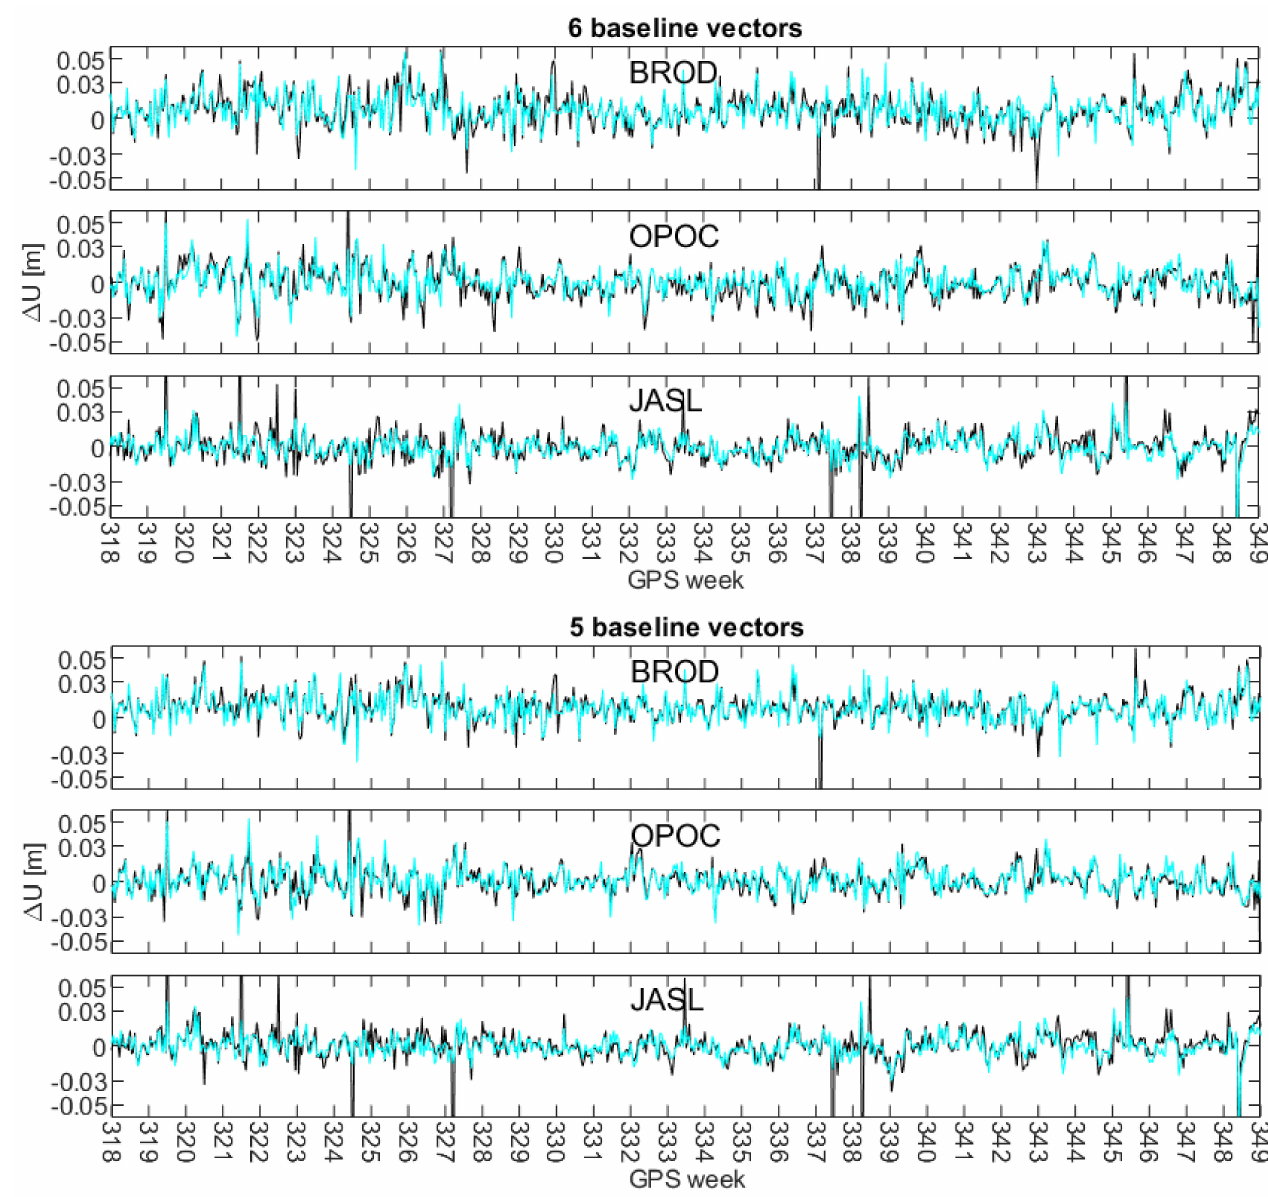
Figure 6. Time series of geometrical height differences with respect to the reference values of the analysed points for EAM (black) and UAM (cyan) using baseline vectors to the six and five nearest ASG-EUPOS